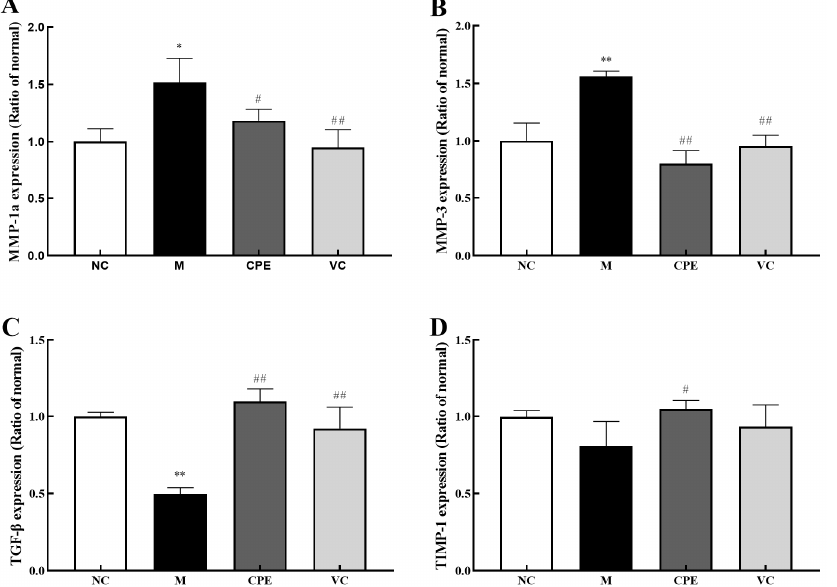
Figure 6. MMP-1a, MMP-3, TIMP-1 and TGF- β levels in mice skin. Note: ( A ): MMP-1a content in mouse skin tissue; ( B ): MMP-3 content in mouse skin tissue; ( C ): TGF- β content in mouse skin tissue;